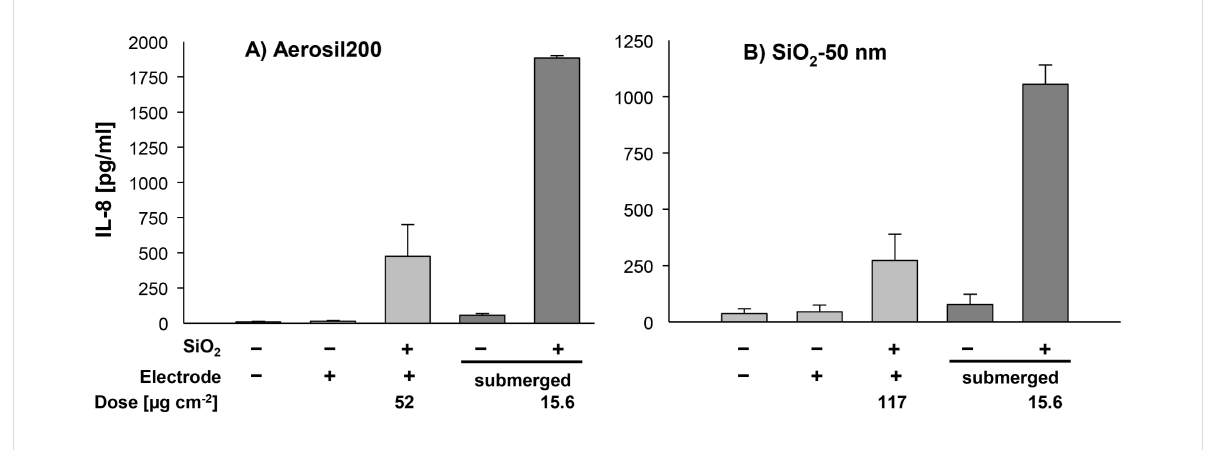
Figure 8: Release of IL-8 from A549 cells after submerged and ALI exposure to Aerosil200 and SiO 2 -50 nm NP agglomerates. A549 cells were exposed to filtered air or to an aerosol containing Aerosil200 NPs (A) and SiO 2 -50 nm NPs (B) under ALI or submerged conditions as described in Figure 7 above. IL-8 concentrations in the medium are represented as means ± s.e.m. of 4 to 6 samples originating from three (A) and two inde- pendent experiments